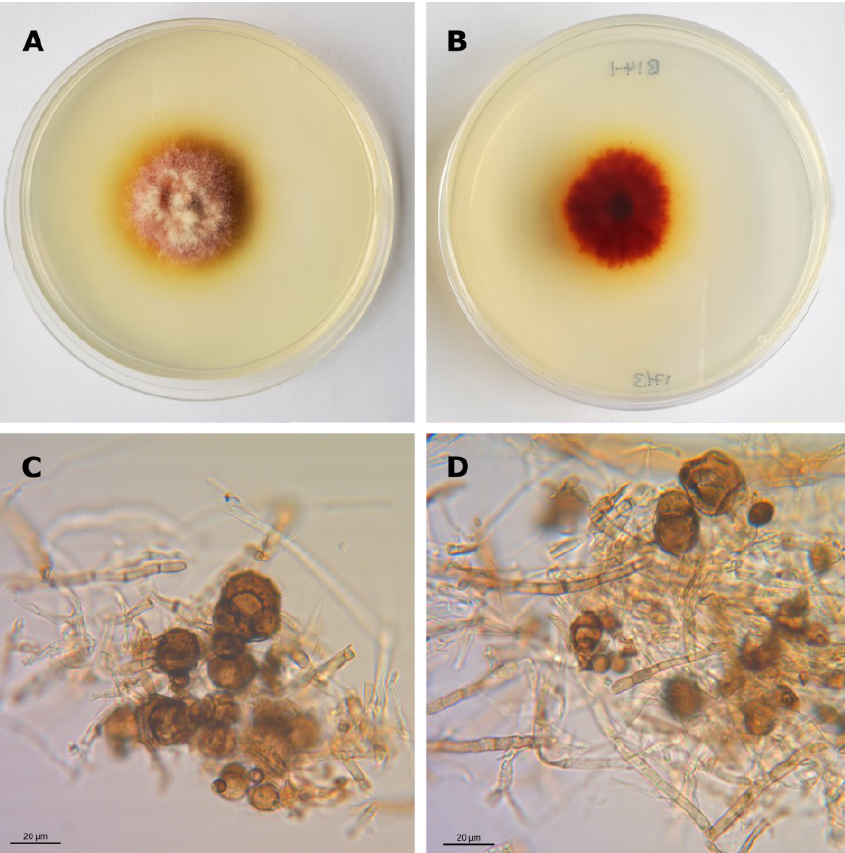
Figure 1. E. nigrum B141 colony, mycelium, and spore morphology. Front ( A ) and back ( B ) of of 5-day old B14-1 culture on PDA Representative microscopy images of B14-1 mycelium fragments and conidia at different maturity stages ( C , D ).